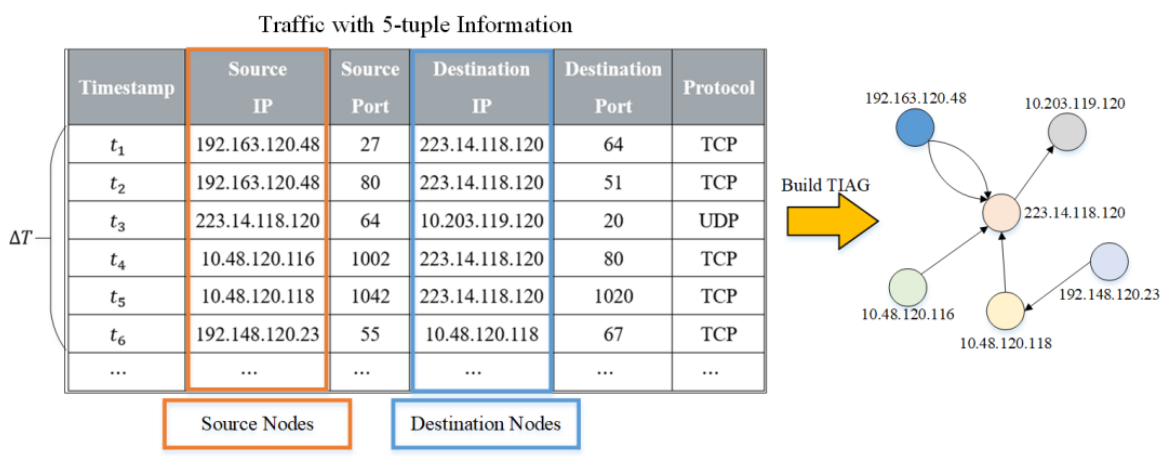
Figure 3. Interaction patterns of three common attacks.